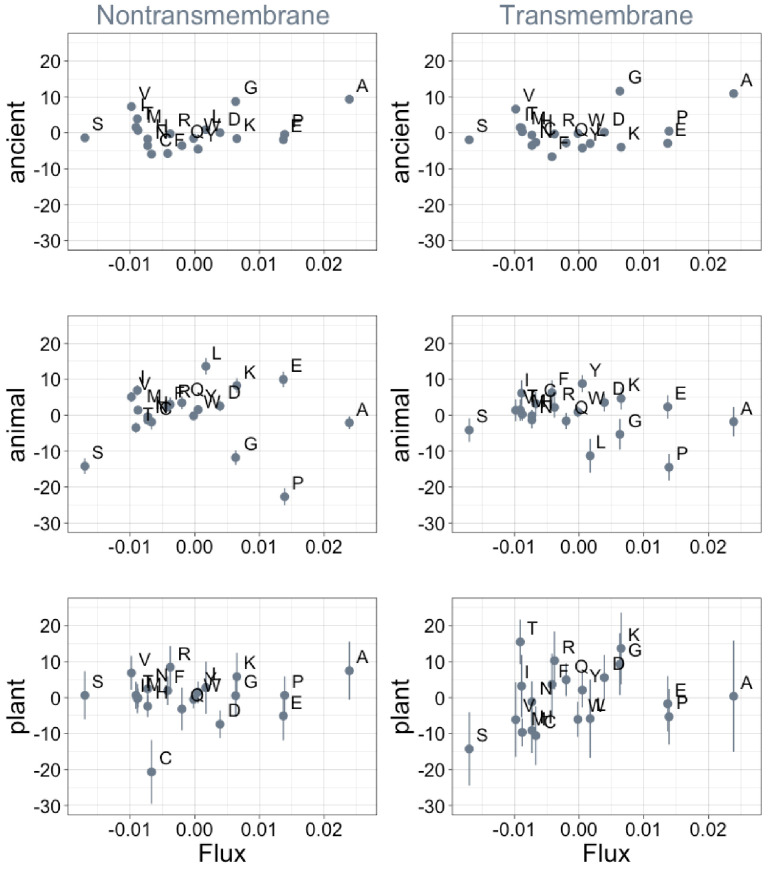
Phylostratigraphy slopes are not significantly correlated with the amino acid flux estimates of Jordan et al., 2005.Phylostratigraphy slopes are in units of percentage points of composition per billion years. Lines indicate the standard errors on the slopes. ‘Ancient’ refers to pfams older than 2101 MY (nontransmembrane and transmembrane, Spearman’s p = 1.0 and 0.7), calculated over all lineages, whereas ‘animal’ (nontransmembrane and transmembrane, Spearman’s p = 0.7 and 0.6) and ‘plant’ (nontransmembrane and transmembrane, Spearman’s p = 0.9 and 0.2) slopes are calculated over pfams appearing after the divergence between the animal/fungi and plant lineages, 1496 MY, assessed in only animal or only plant instances.